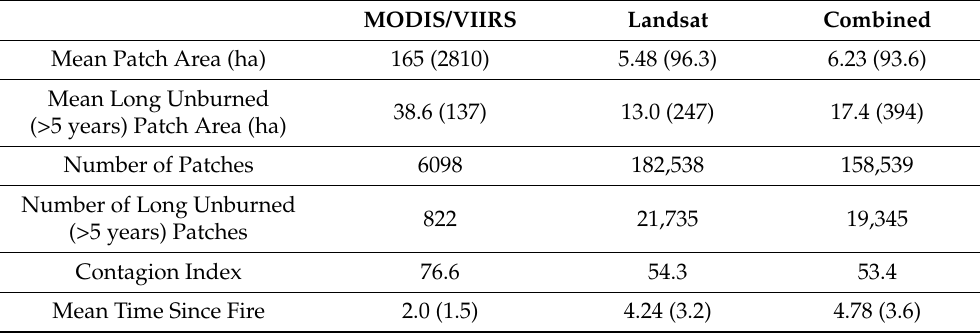
Table 1. Landscape metrics calculated on 2021 time since fire map based on MODIS/VIIRS, Landsat and the combined method. Numbers in parentheses indicates standard